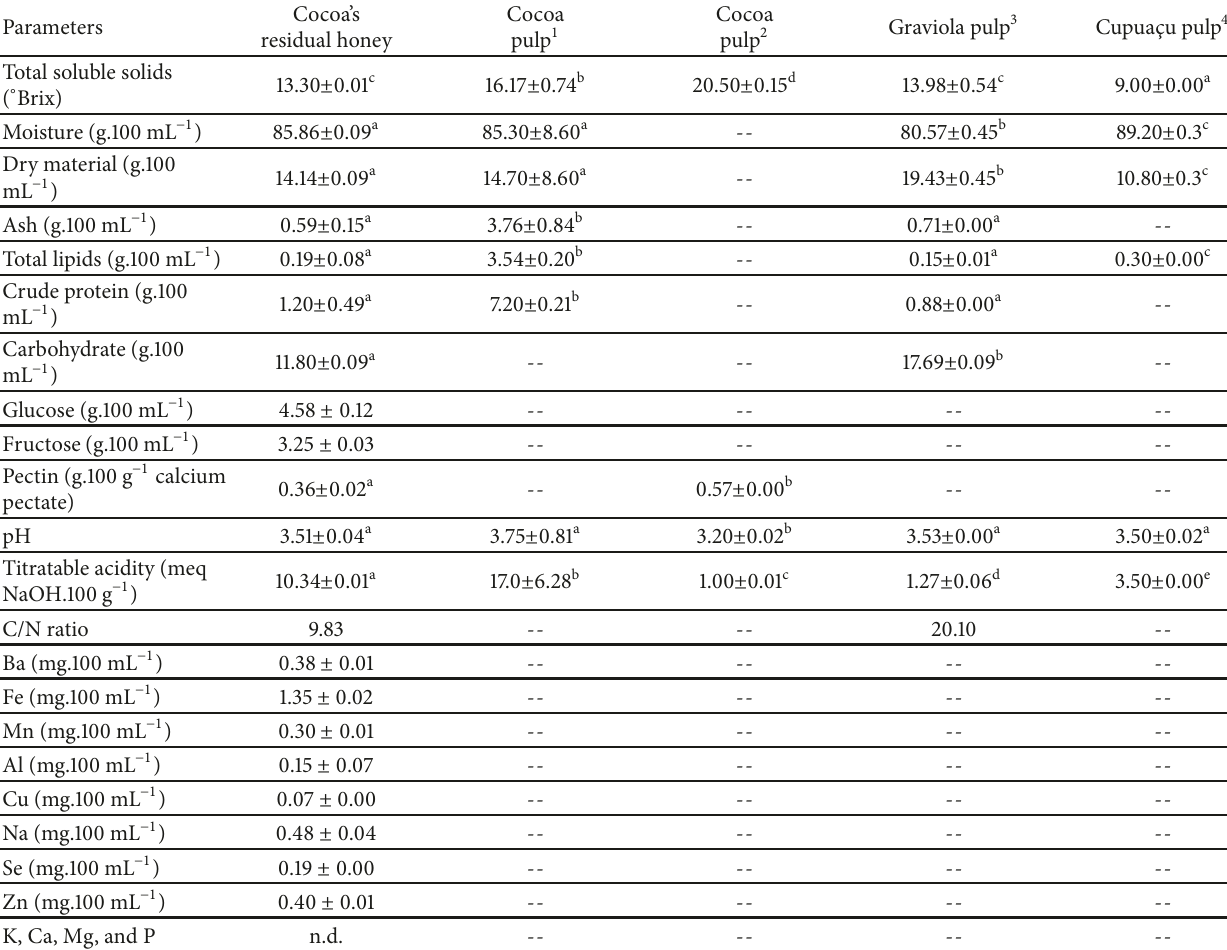
Table 1: Physicochemical characterization of cocoa’s residual honey compared to other fruit pulps (the mean ± standard deviation).